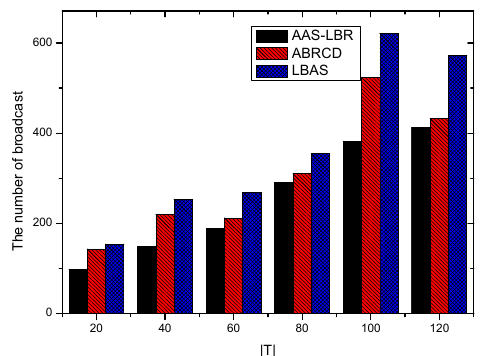
Figure 42. The impact of |𝑇| with fixed network nodes = 400 with fixed on the total number of broadcast.